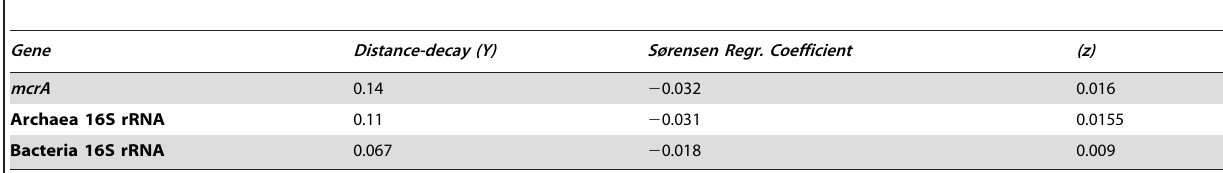
Table 1. Distance-decay regression coefficients based on the Bray-Curtis dissimilarity index (Y) ; Regression coefficient based on the Sørensen Similarity index; and the exponent z calculated by the distance-decay approach values for each one of the target genes calculated by -(regression